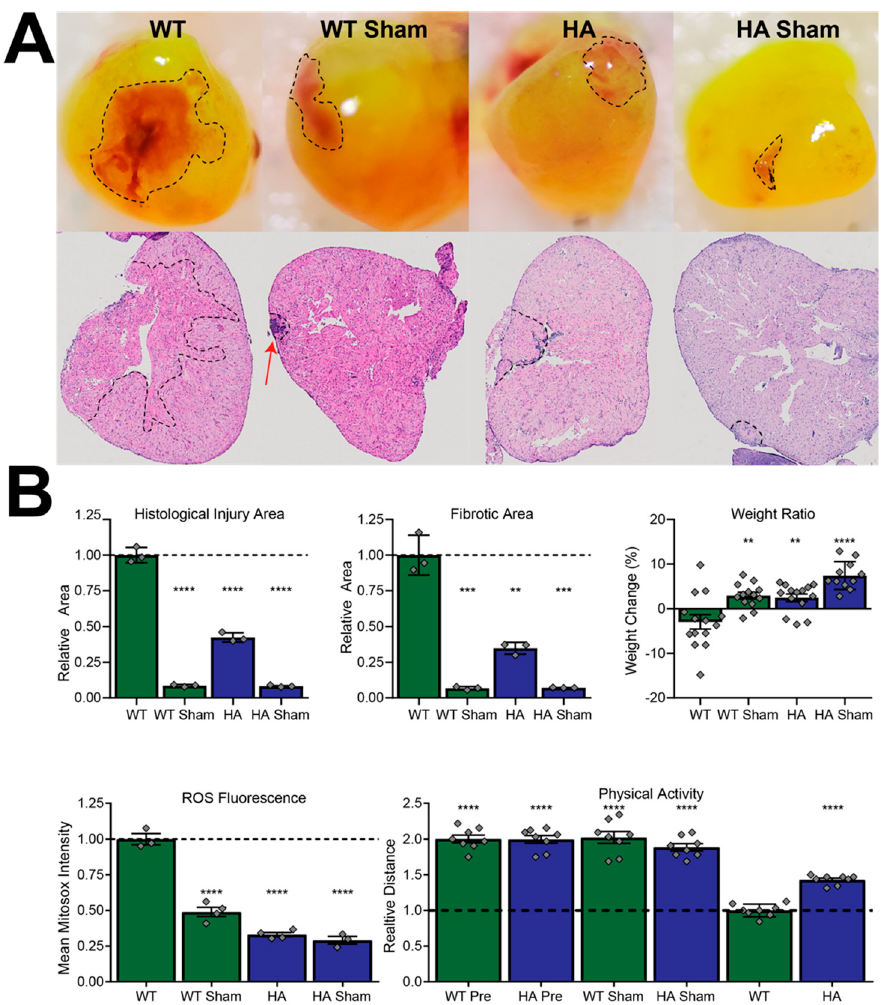
Figure 6. p66Shc hypomorphic allele improves MI outcome determinants in a ROS-dependent manner. ( A ) Representative stereomicroscopy images (top) and H&E stains (bottom) of resected hearts. ( B ) Quantification of zebrafish body mass effects, physical activity, and MI parameters from panel A. Hypomorphic allele zebrafish denoted as “HA”. **** = p -value < 0.0001, *** = p -value < 0.001, ** = p -value < 0.01, N = 7 independent fish for each measurement and presented as mean ± SD, N = 14 (weight ratio), N = 3 (injury and fibrotic area), N = 3 or 4 (ROS fluorescence), and N = 8 (physical